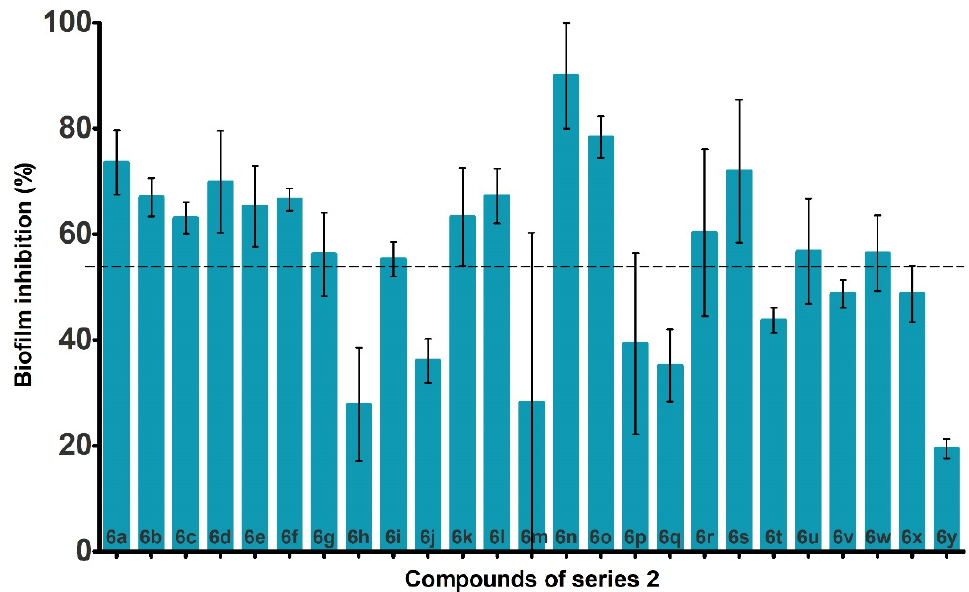
Figure 4. Anti-biofilm activity against P. aerugiosa PAO1 of retro chromone carboxamides ( 6a-y ) at 50 µ M, expressed as inhibition % (GraphPad 5.0).